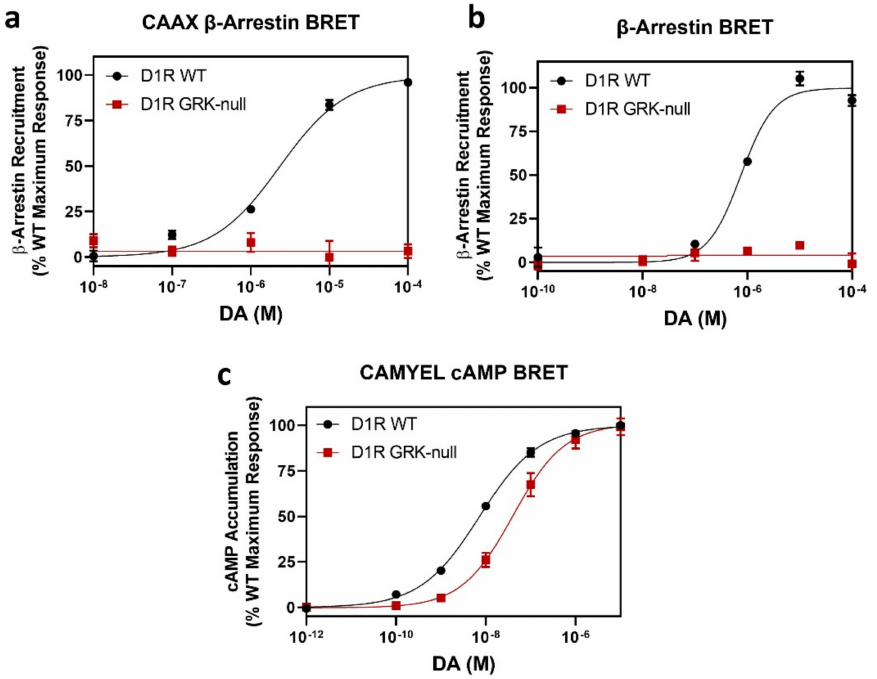
Figure 7. Creation of a “GRK-null” D1R through simultaneous mutation of the GRK-mediated phosphorylation sites ablates β -arrestin recruitment to the D1R. The GRK-null construct is delin- eated in Figure 1 with red lettering/numbering. CAAX β -arrestin recruitment, CAMYEL cAMP accumulation, and direct D1R- β -arrestin BRET assays were performed as described in Section 4. ( a ) CAAX β -arrestin recruitment assays: D1R WT EC 50 = 2.4 ± 0.1 µ M, Emax = 100%; D1R GRK-null EC 50 = undefined, Emax = 4.4 ± 2.7% ****. ( b ) Direct D1R- β -arrestin recruitment BRET assays: D1R WT EC 50 = 0.8 ± 0.07 µ M, Emax = 100%; D1R GRK-null EC 50 = undefined, Emax = 5.1 ± 3.0% ****. ( c ) CAMYEL cAMP accumulation assays: D1R WT EC 50 = 7.4 ± 0.7 nM, Emax = 100%; D1R GRK-null EC 50 = 45 ± 9.9 nM **, Emax = 101 ± 4.4%. Data are expressed as a percentage of the maximum D1R WT response to DA and are shown as the mean ± SEM of at least three experiments performed in triplicate. Statistical comparisons between the D1R WT and mutant curve parameters were made using a t -test: ** p < 0.01, and **** p <